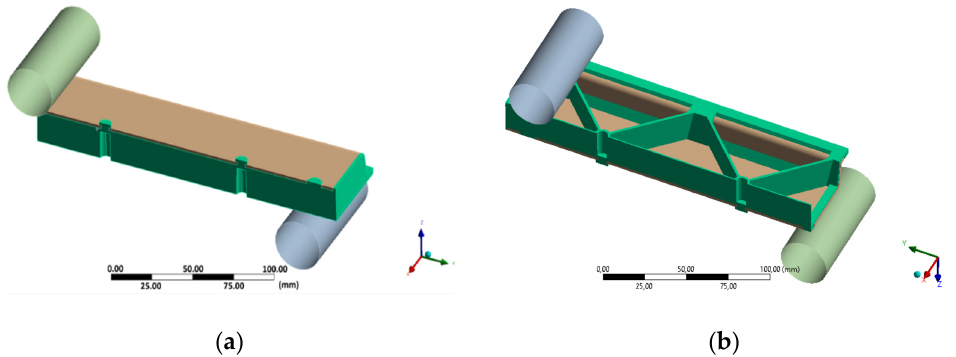
Figure 12. Quarter model of the three-point flexural test of the hybrid injection molded thermoplastic composite test structure. The injection molded PP/GF30 short fiber-reinforced thermoplastic composite is shown in green and the PP/GF60 continuous fiber-reinforced thermoplastic composite in brown: ( a ) top view and ( b ) bottom view.